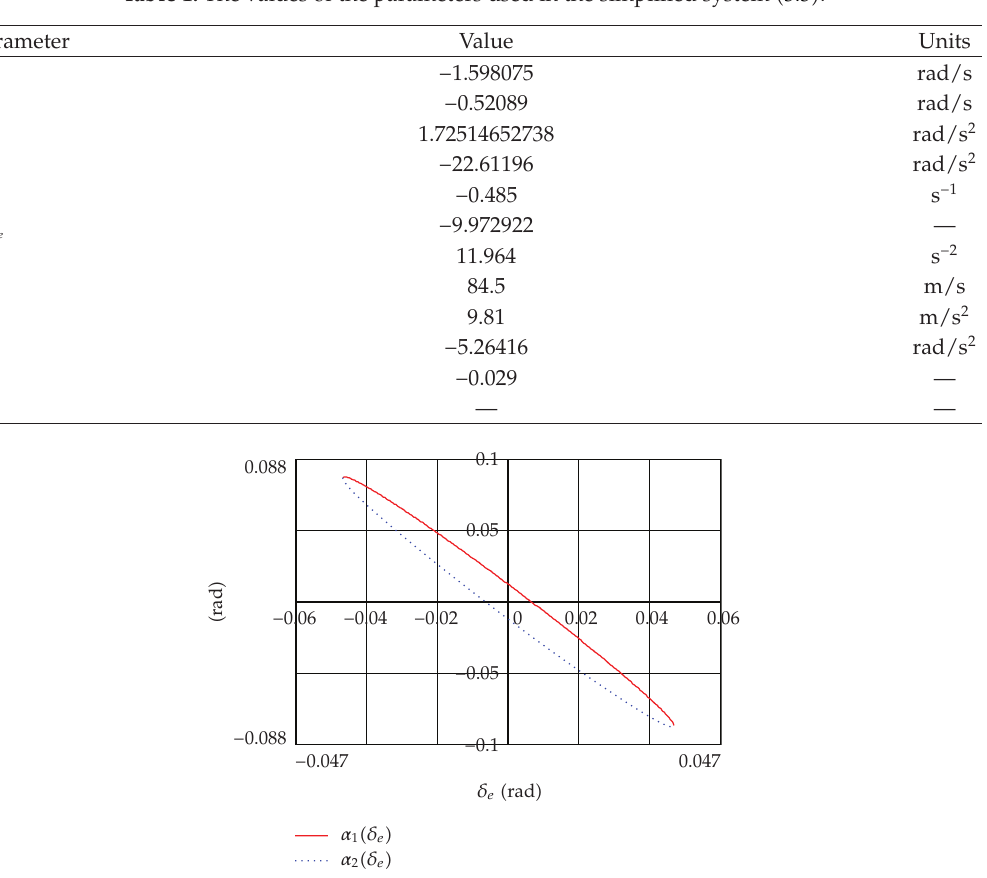
Table 1: The values of the parameters used in the simplified system (cid:3) 3.3 (cid:4) .